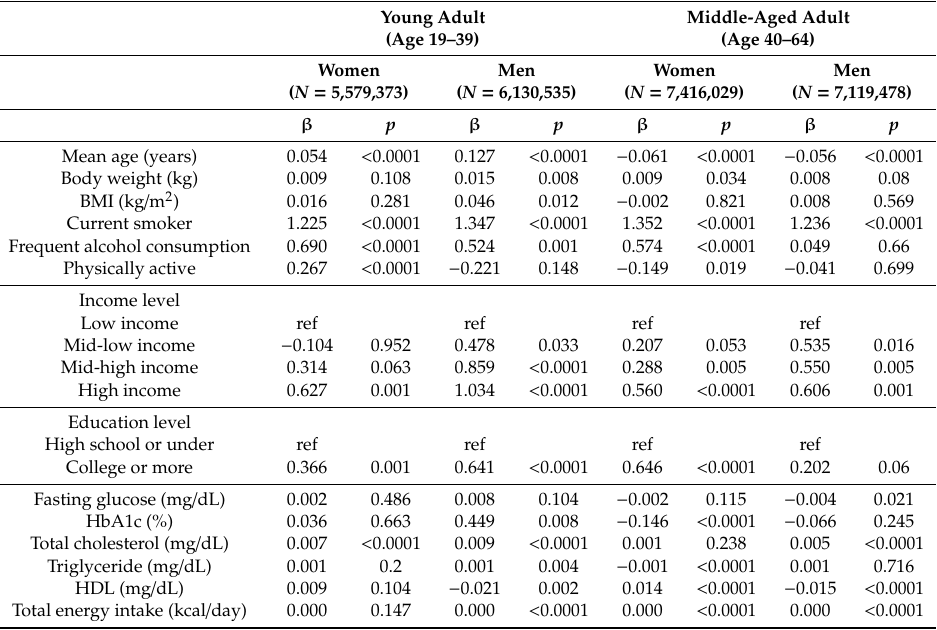
Table 4. Association between the amount of daily co ff ee consumption and other covariates.